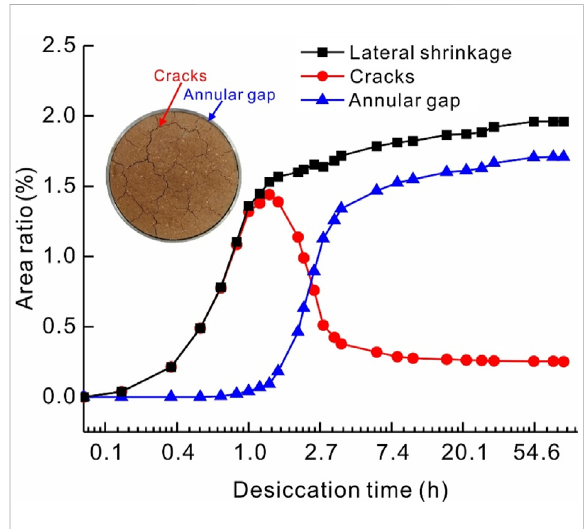
FIGURE 6 Variationsoflateralshrinkageofspecimenversusdryingtime. The lateral shrinkage consists of cracks on specimen surface and annular gap between the rigid ring and specimen.